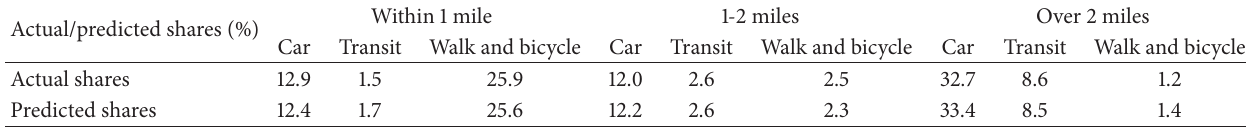
Table 6: Comparisons between actual shares and predicted shares using sample enumeration.